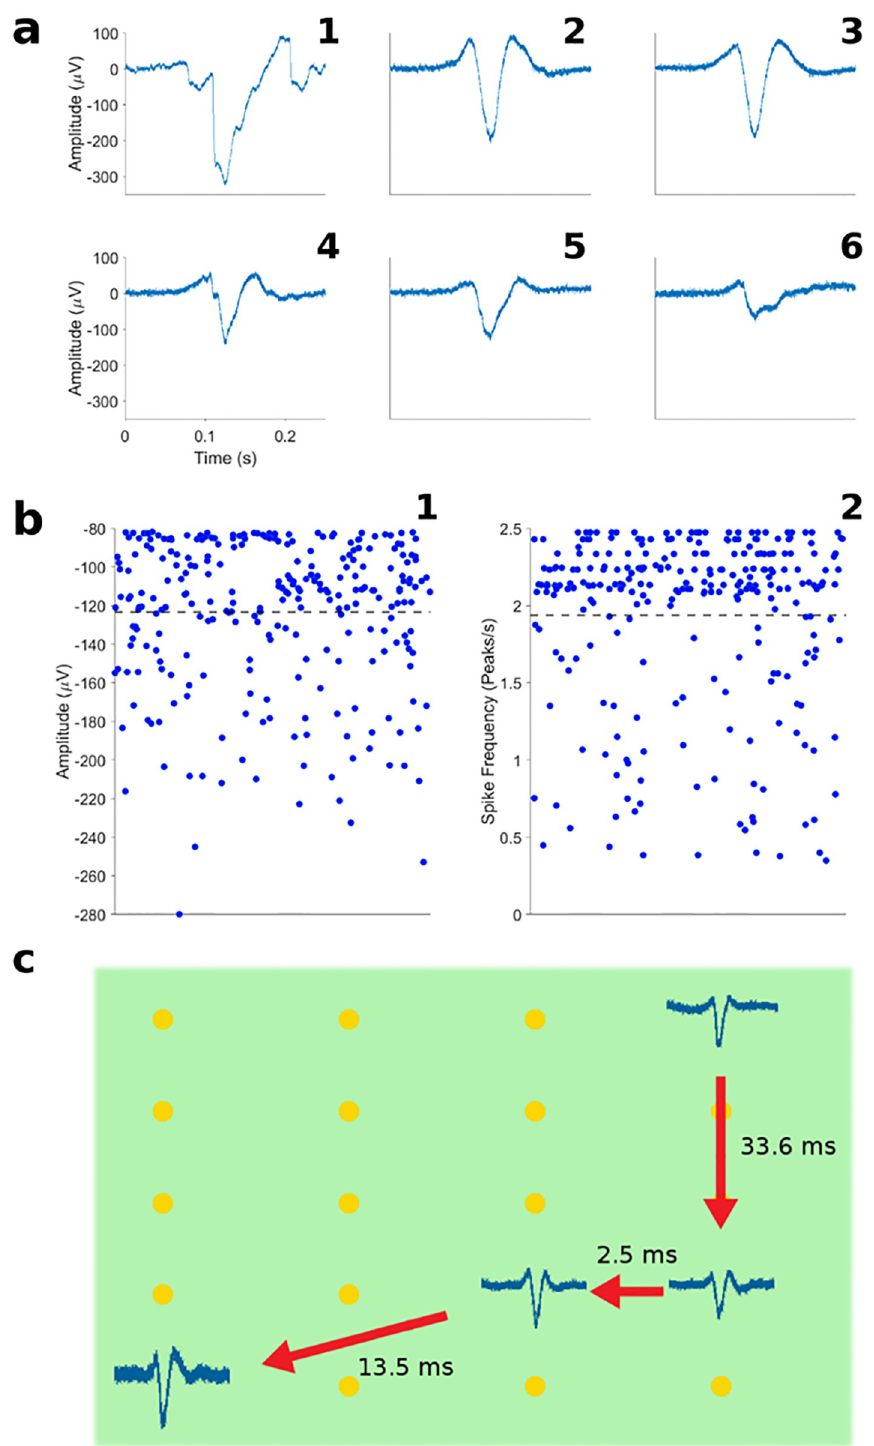
Fig 4. Extracellular signals. a) Waveforms of detected spikes with different amplitudes. b) 1. Distribution of the average spike amplitudes per electrode. 2. Distribution of spike frequencies per electrode. c) Propagation of sequential APs across the surface of an MEA chip. The detected spikes were placed on the 2D location of the electrodes where they were detected. In the image, four spikes detected sequentially in time are shown in their location on the chip surface. The direction of the arrows indicates the temporal order of the spikes, with the time between APs annotated next to the arrows.